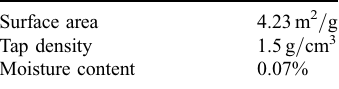
TABLE I Composite Powder